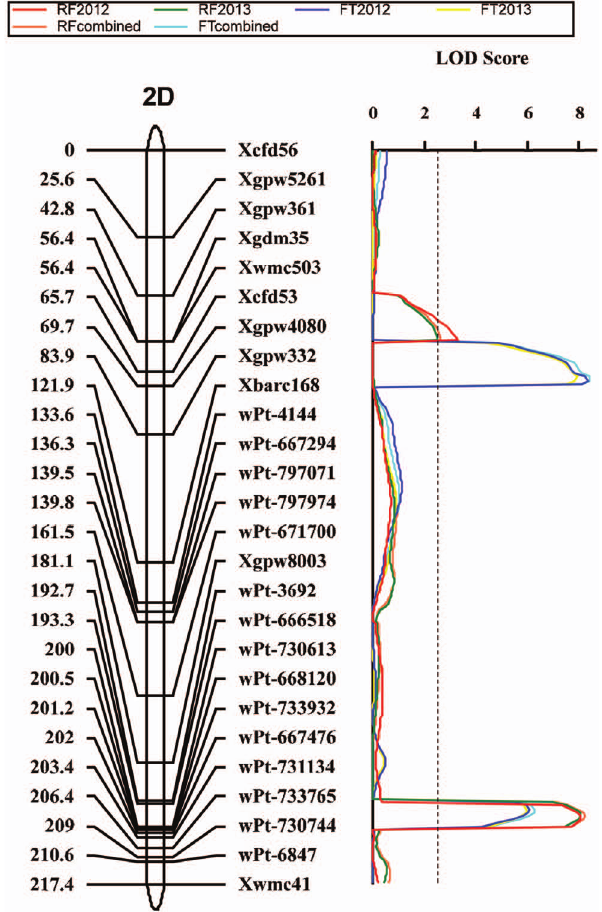
Figure 4. Quantitative trait loci (QTLs) for brittle rachis and threshability. QTL detected on chromosome 2D in the Triticum aestivum ssp. tibetanum Shao population from accessions Q1028 6 ZM9023. Marker positions are shown on the right of the linkage map, and distances between loci (in centimorgans, cM) are shown on the left. The vertical dashed line indicates the significance threshold (LOD 5